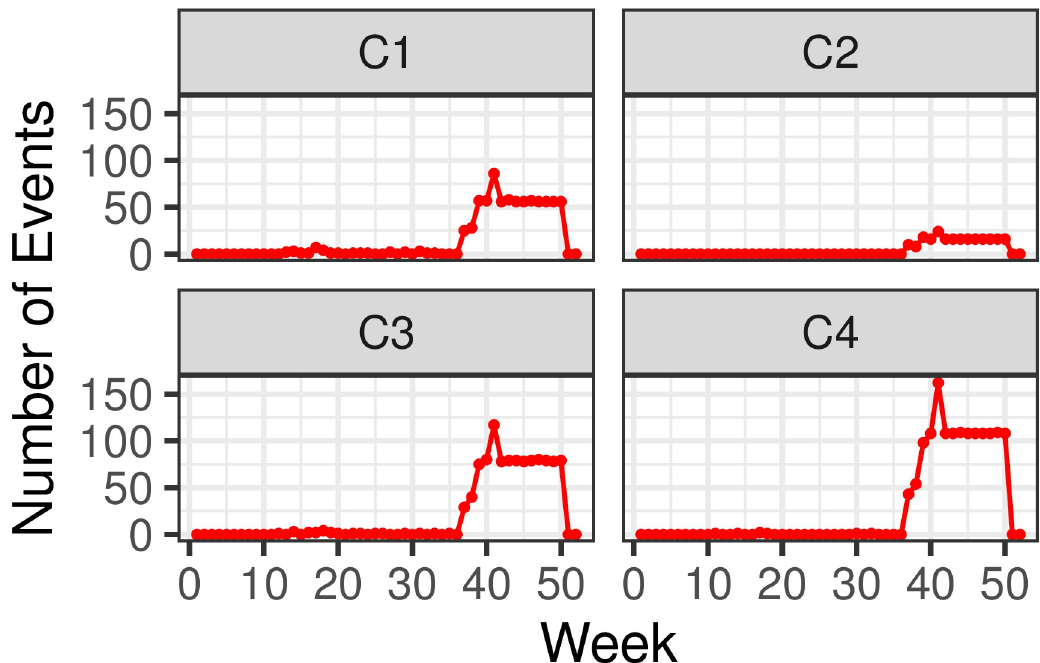
Fig 8. Weekly time series of disorder events { n j } visualized by cluster, in Israel. Weeks are marked from week j = 1 (December 29 th 2019 to January 4 th 2020) to week j = 50 (December 6 th to December 12 th 2020).